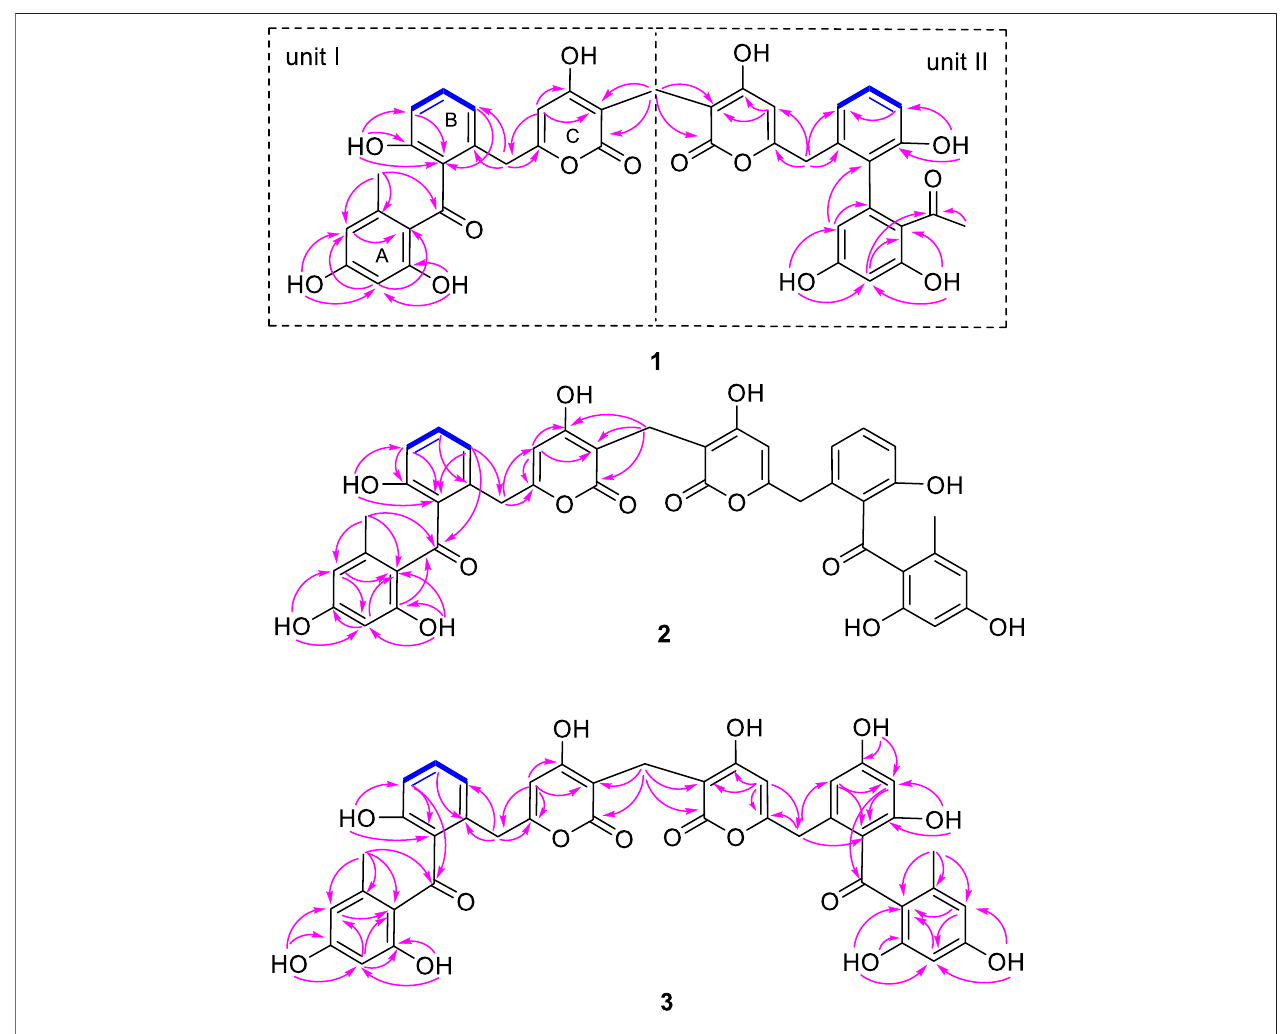
FIGURE 2 | Key COSY (bolds, blue), HMBC (arrows, pink) correlations of 1 ‒ 3.